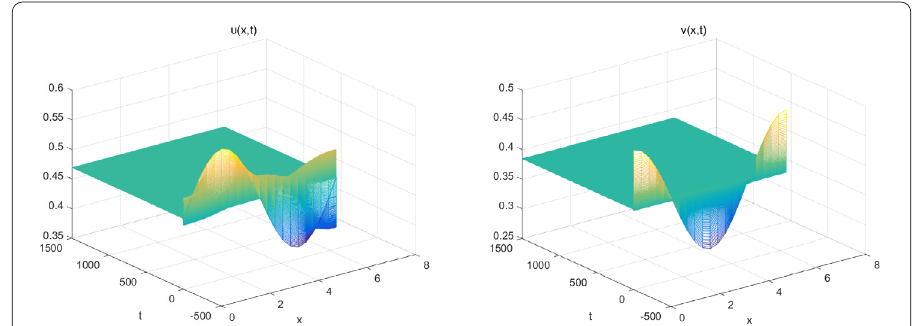
Figure 1 Numerical simulations of system (1.3) for τ = 1.5